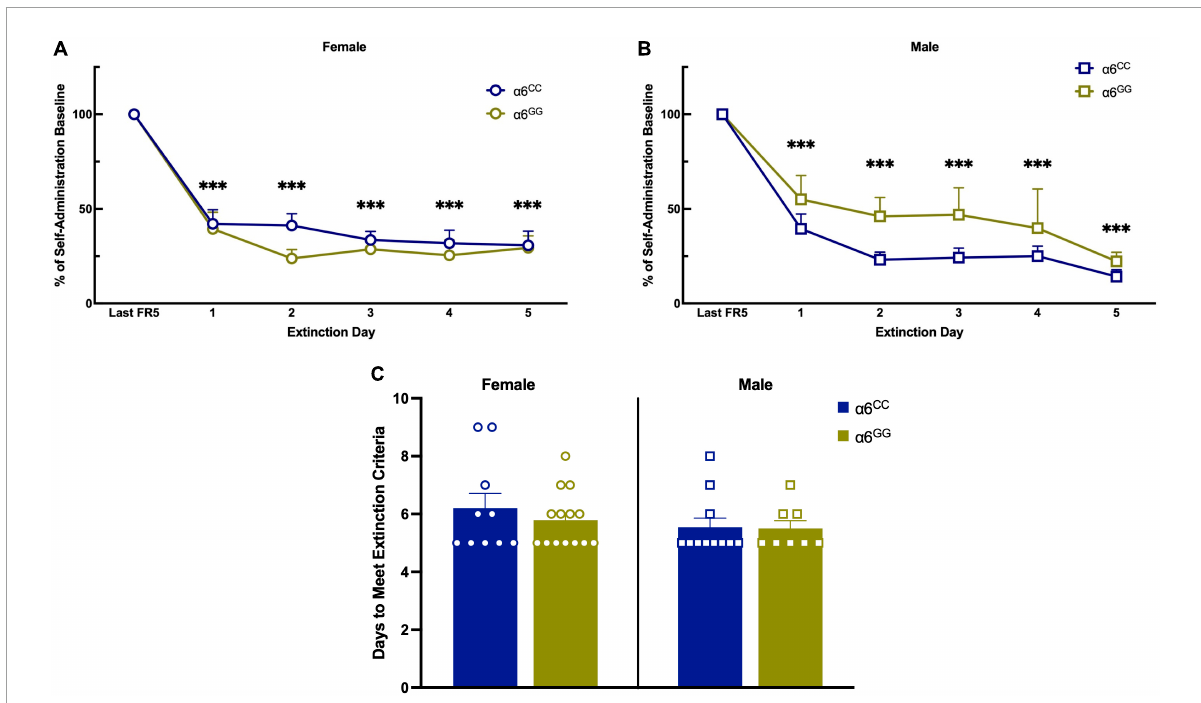
FIGURE4 The human CHRNA 6 3 (cid:48) -UTR SNP does not influence extinction. After completion of nicotine self-administration, female (A) and male (B) , α 6 CC and α 6 GG , were allowed to respond on the reinforced and non-reinforced lever without schedule consequence (e.g., infusion of nicotine, cue light and tone). Data are presented as a mean ± SEM percent of the last day of nicotine self-administration responding. No genotype or sex differences were observed for days to meet extinction criteria (C) . ∗∗∗ p < 0.001 vs. Last FR5. N = 8–14/group. Circles represent females and squares represent males.